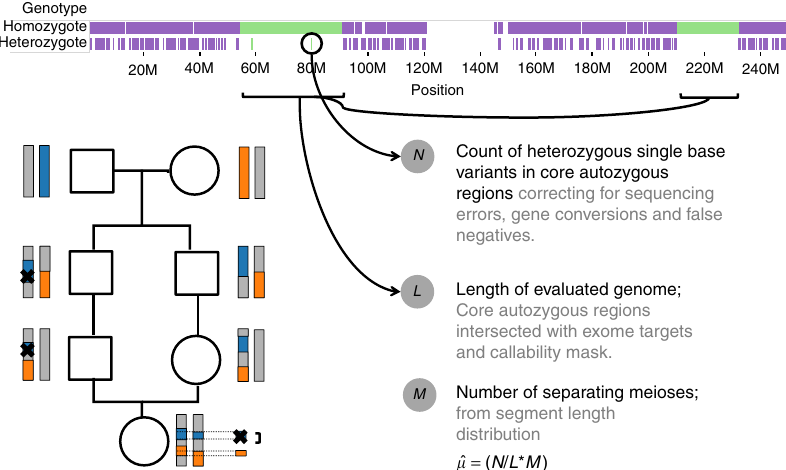
Fig. 1 Study design: strategy to estimate the mutation rate. Bottom left : regions of the genome in an individual with fi rst cousin parents are autozygous due to being inherited by two routes from a common founding chromosome. The X marks represent a DNM transmitted along the pedigree to the sequenced individual. Top : most sites in autozygous regions are homozygous, except for recent mutations, gene conversions and sequencing errors. Bottom right : the estimate ^ μ depends on three factors: N , L and M , as described in the